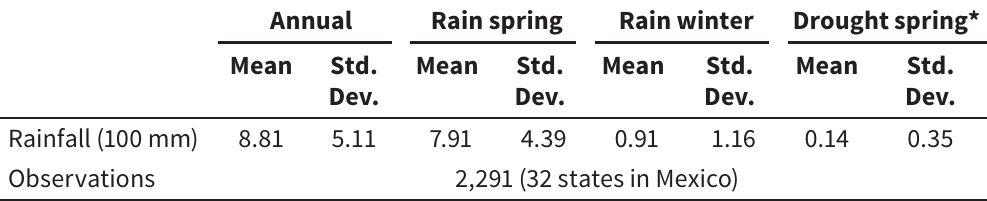
Summary statistics for state level rainfall in Mexico from 1941 to